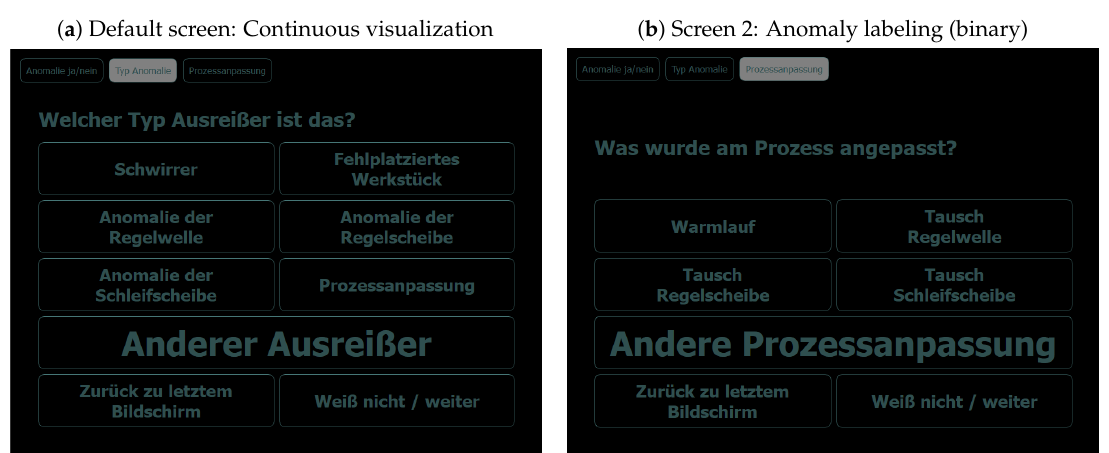
Figure A1. Screens of the visualization and labeling prototype (original German version). A version of the screens translated to English can be found in Figure 4. A detailed description of the functional workflow of the screens can be found in Section